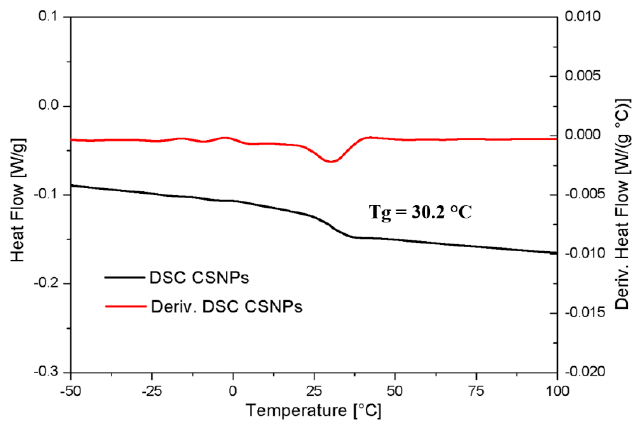
Figure 7. DSC and derivative differential scanning calorimetry curves of CSNPs.